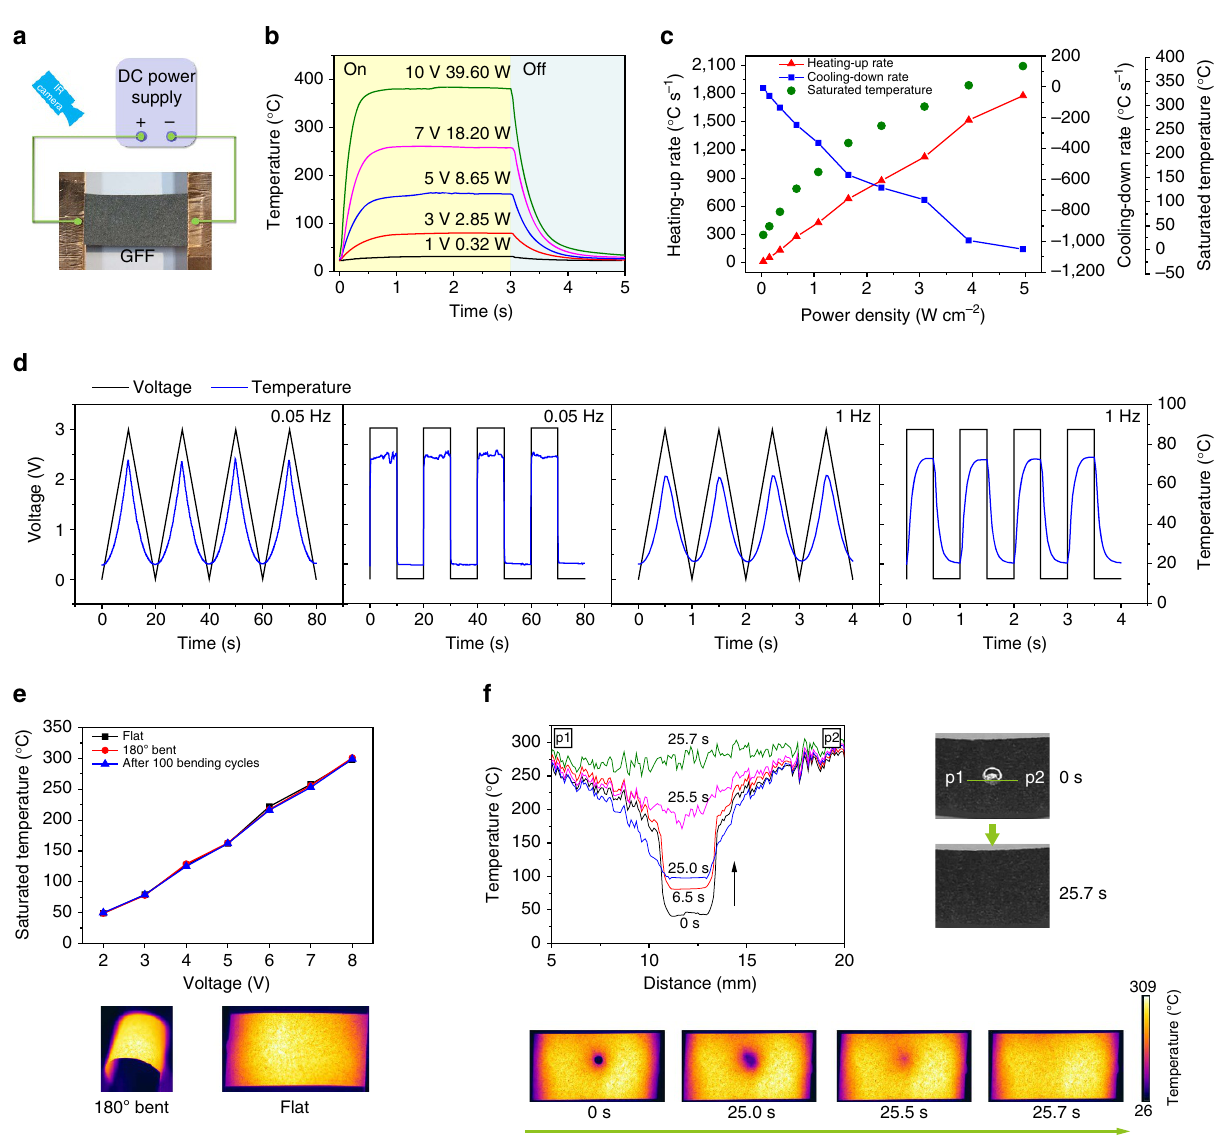
Figure 7 | Electrothermal performance of GFFs. ( a ) Diagram of experimental set-up for GFF electrothermal heaters. ( b ) Temperature profiles of a strip of GFF (4 (cid:2) 2cm 2 ) at different applied voltages. ( c ) Peak values of heating-up and cooling-down rates and the corresponding saturated temperatures as a function of input electrical power density. ( d ) Frequency-dependent responses of a thinner GFF strip (20 (cid:2) 1.5mm 2 ) at 0.05 and 1Hz, with applied triangular wave and pulsed squared wave from 0 to 3V. ( e ) Top: saturated temperature of a GFF heater at various voltages in flat state, 180 (cid:2) curved state and after bending for 100 times. Bottom: infrared pictures of the GFF heater in flat and 180 (cid:2) bent state. ( f ) Top left: temperature evolution across the central line of a water droplet with respect to time. Top right: photos indicating the concerned region from p1 to p2, and showing the evaporation of the water droplet. Bottom: infrared pictures following the droplet evaporation